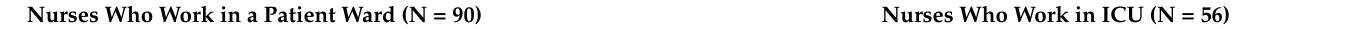
Table 5. General characteristics, fatigue, depression, insomnia, sleepiness, and occupational stress according to the history of providing care for COVID-19 patients (N = 146). Nurses Who Work in a Patient Ward (N = 90) Nurses Who Work in ICU (N =